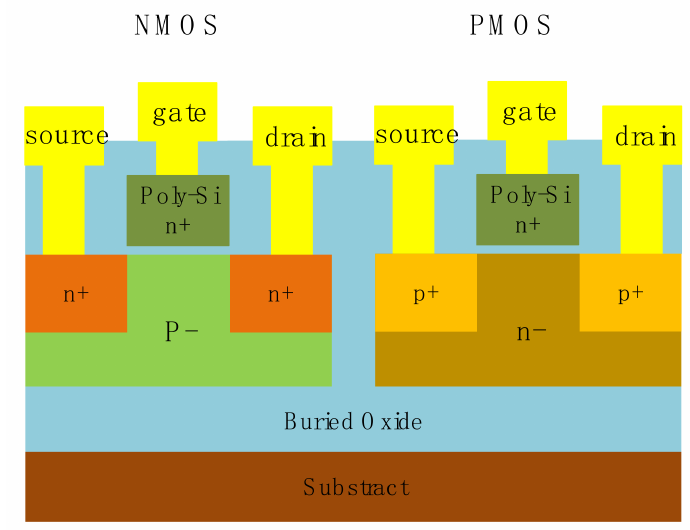
Figure 4. SOI CMOS structure